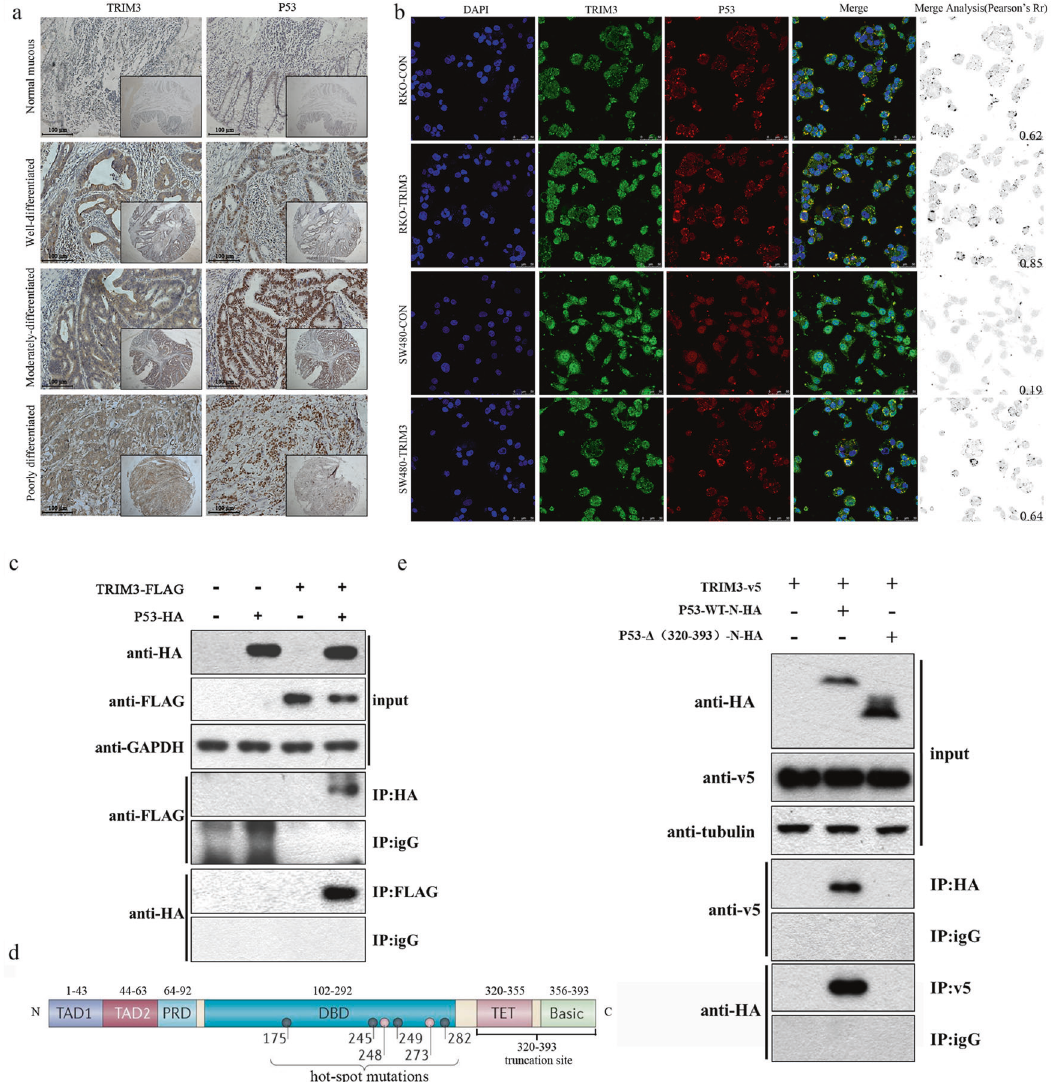
Fig. 3 TRIM3 close correlation with p53 in expression and direct binding with p53 at the C terminus. a The expression and relationship between TRIM3 and p53 in the identical area of different differentiated cancer by immunohistochemistry. Original magni fi cation ×50 and ×200 for inset images; b TRIM3 and p53 co-staining as distinct dots in the cytoplasm of RKO and SW480 cells by confocal microscopy and Image J software; c TRIM3 direct binding with p53. 293 T cells were transfected with plasmids encoding TRIM3-FLAG and P53-HA or empty vectors for 24 h, followed by Co-IP and a western blotting analysis with anti-HA, anti-GAPDH, and anti-FLAG antibodies; d The diagram of p53 hot-spot mutation sites and our designed truncation site; e TRIM3 binding to the C terminus of p53 (residues 320 to 393), a common segment of wild and mutant p53. HA-tagged wtp53 and C-terminal (320 – 393) truncation mutp53 were transfected into 293 T cells expressing v5-TRIM3. After the beads were washed, bound proteins were eluted and analyzed by Western Blot with anti-HA, anti-tubulin, and anti-v5